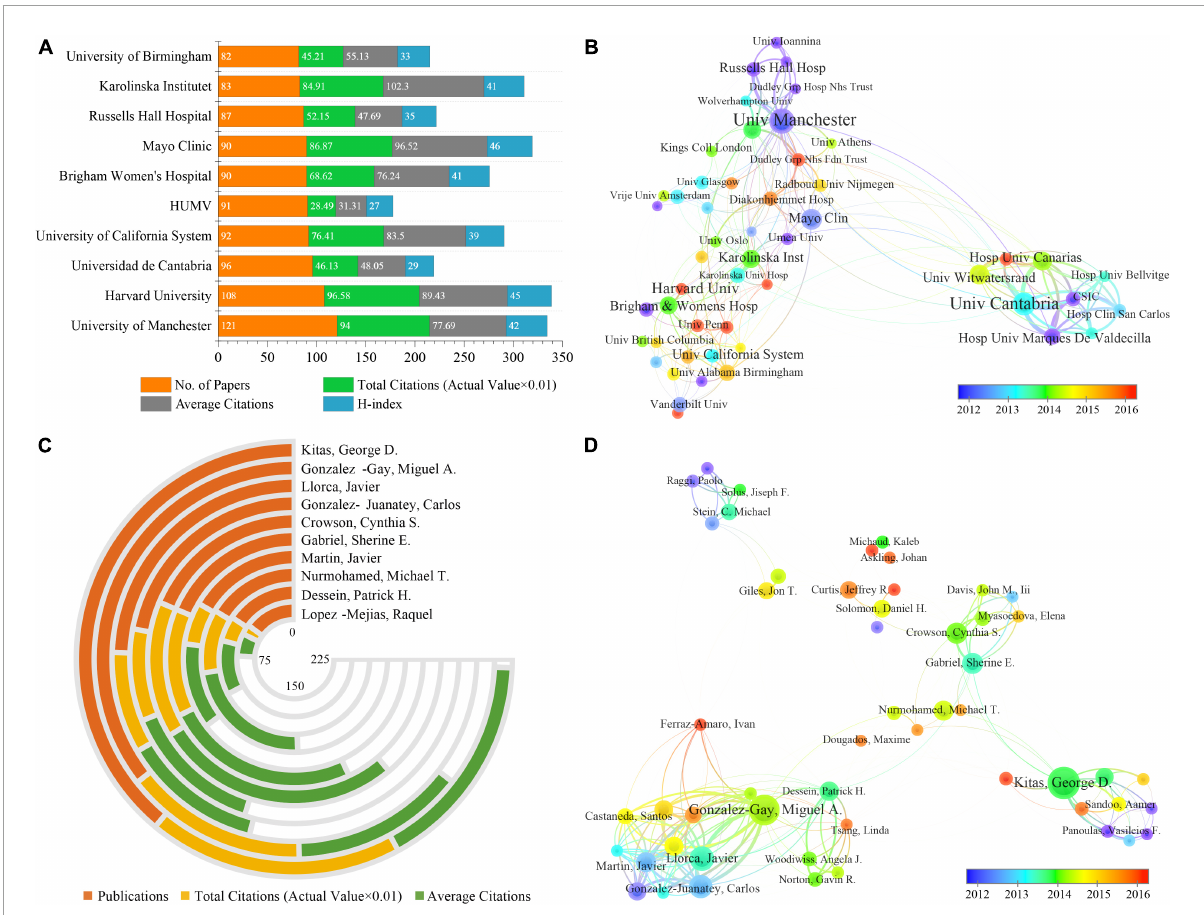
FIGURE3 (A) The publication counts, citations, and H-index of the top 10 prolific institutions. HUMV stands for Hospital Universitario Marqués de Valdecilla. (B) Cooperation network among institutions. (C) The publication counts and citations of the top 10 most productive authors. (D) Cooperation network among authors. The nodes in the graph represent institutions or authors, and lines between the nodes represent collaborative relationships. Nodes are marked with different colors depending on the average appearing year. The thickness of lines between two institutions or authors indicates the strength of cooperation, while the area of nodes represents the number of publications.